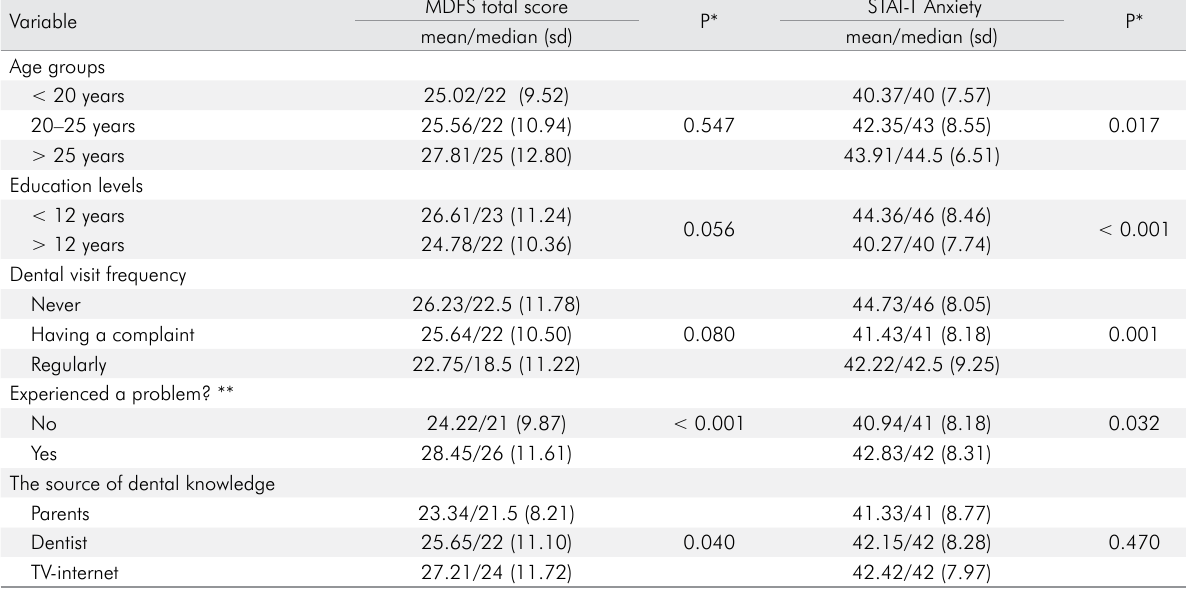
Table 3. Dental fear and trait anxiety comparison in terms of independent variables (n = 607).